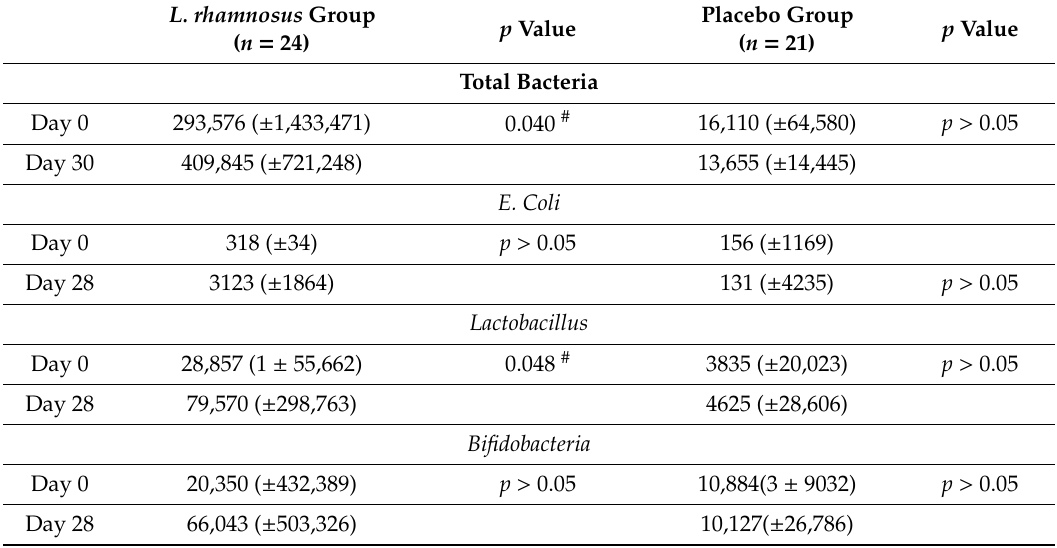
Table 5. Certain bacterial species of gut microbiota (mean ± standard deviation) genome / mg feces , in a group of infants’ Lactobacillus rhamnosus GG (ATCC 53103) or placebo at enrolment Day 0 and after 28 days of